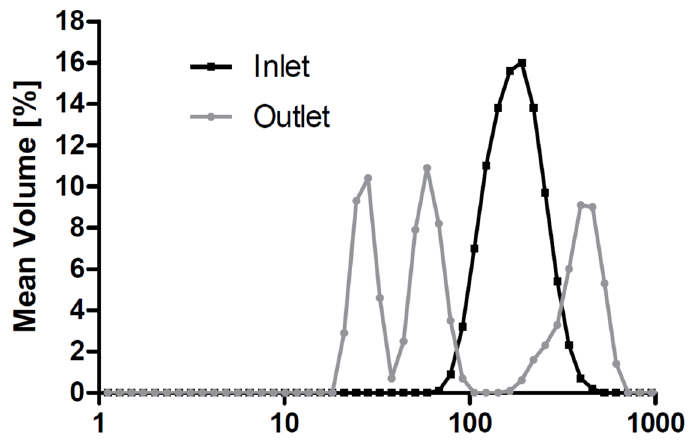
Figure 6. Nanosize particle size distributions measured on ZetaSizer. Inlet samples show monomodal distributions while outlet samples show polymodal distributions. Inlet = untreated runoff stormwater before entering the disc filter, outlet = treated water after passing through the 10 µm disc filter. Note the logarithmic scale on the horizontal